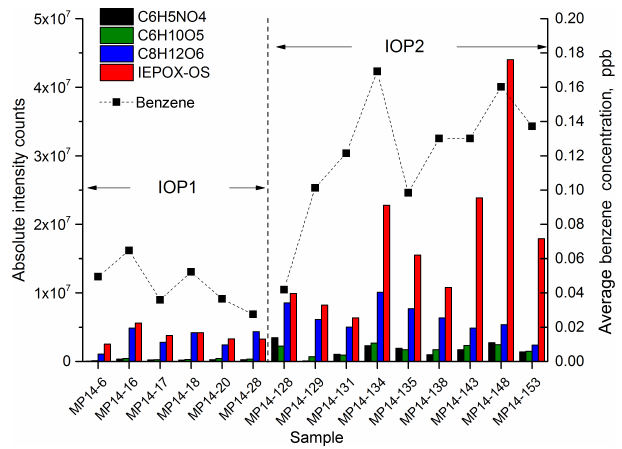
Figure 4. Ion intensity distributions (left axis) of selected tenta- tively identified markers in individual samples using UHRMS anal- ysis and averaged benzene concentration (right axis) from PTR- TOF-MS analysis. Benzene concentration was averaged for the aerosol filter sampling intervals. The UHRMS data were corrected for organic carbon load in each individual filter sample (see Meth- ods